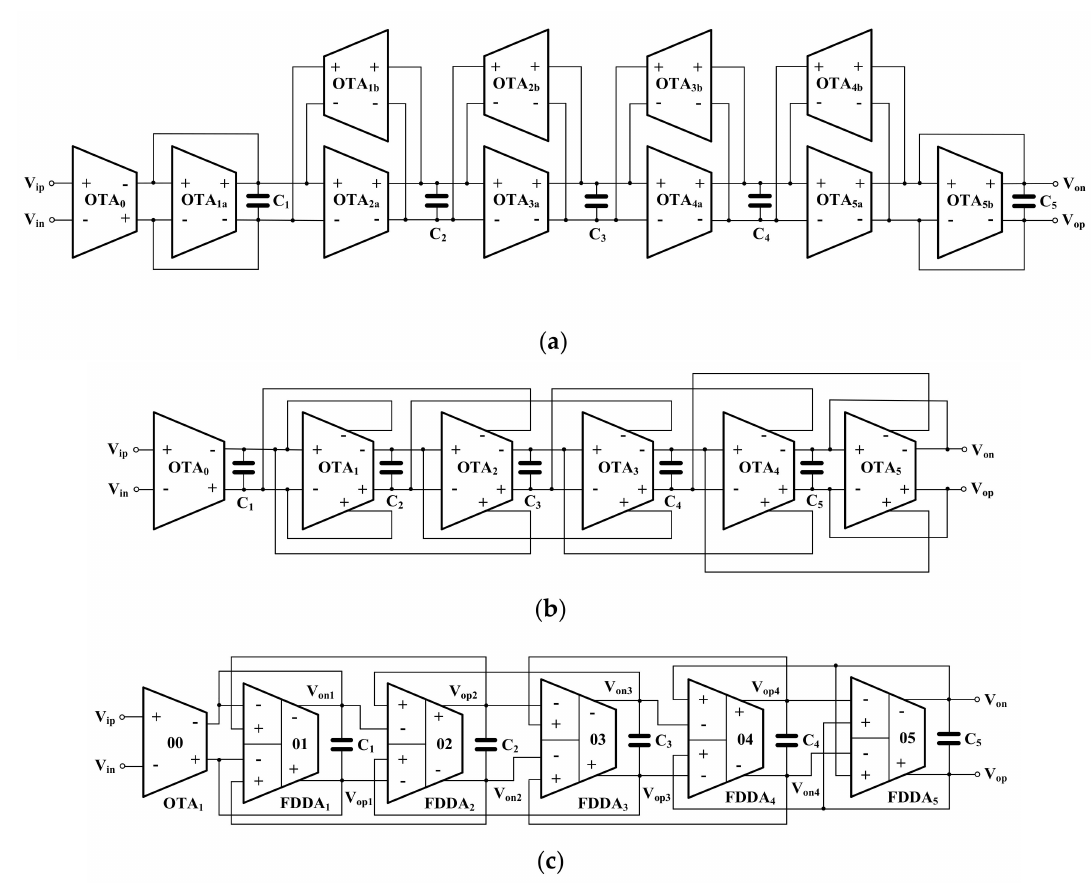
Figure 3. Fifth-order Butterworth low-pass filters, ( a ) FD-OTA-C filter [7], ( b ) MOFD-OTA-C filter [8,9], ( c ) FDDA-based filter